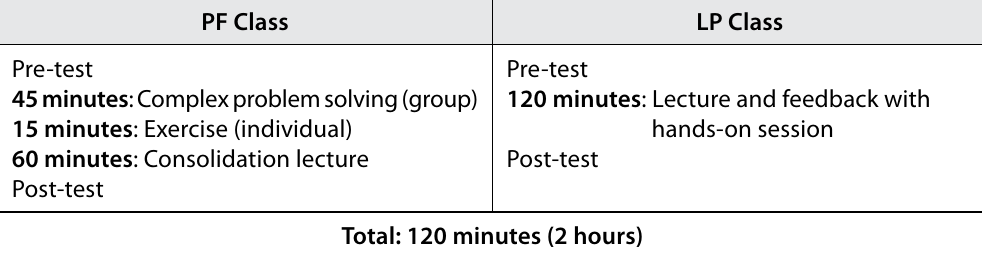
Table 1 PF versus